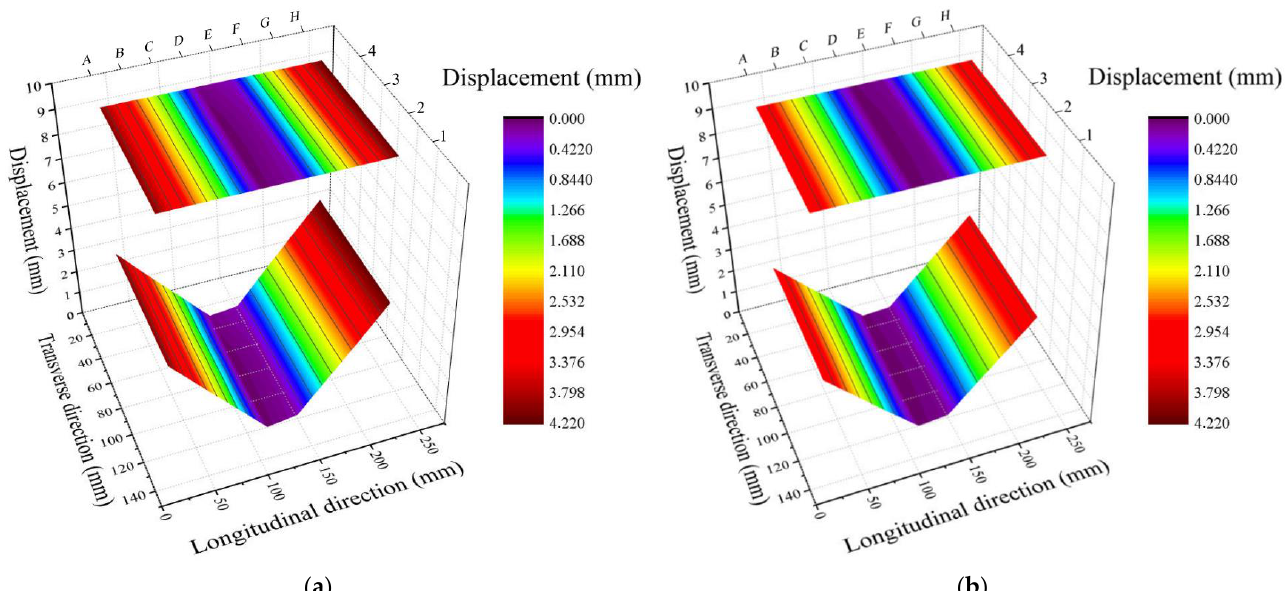
Figure 10. ( a ) The deformation graph for multipass with a single orientation (M[s]); ( b ) the deformation graph for multipass with alternated orientation (M[a]).